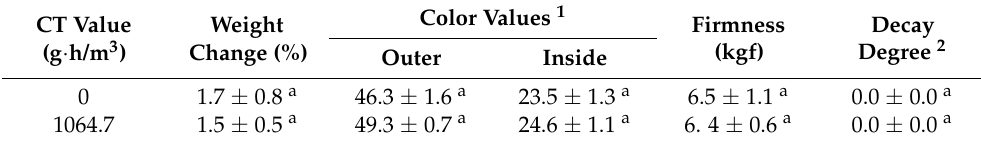
Table 2. Phytotoxic effects of fumigation on chestnut for 12 h at 15 ◦ C (filling ratio = 2.5%).